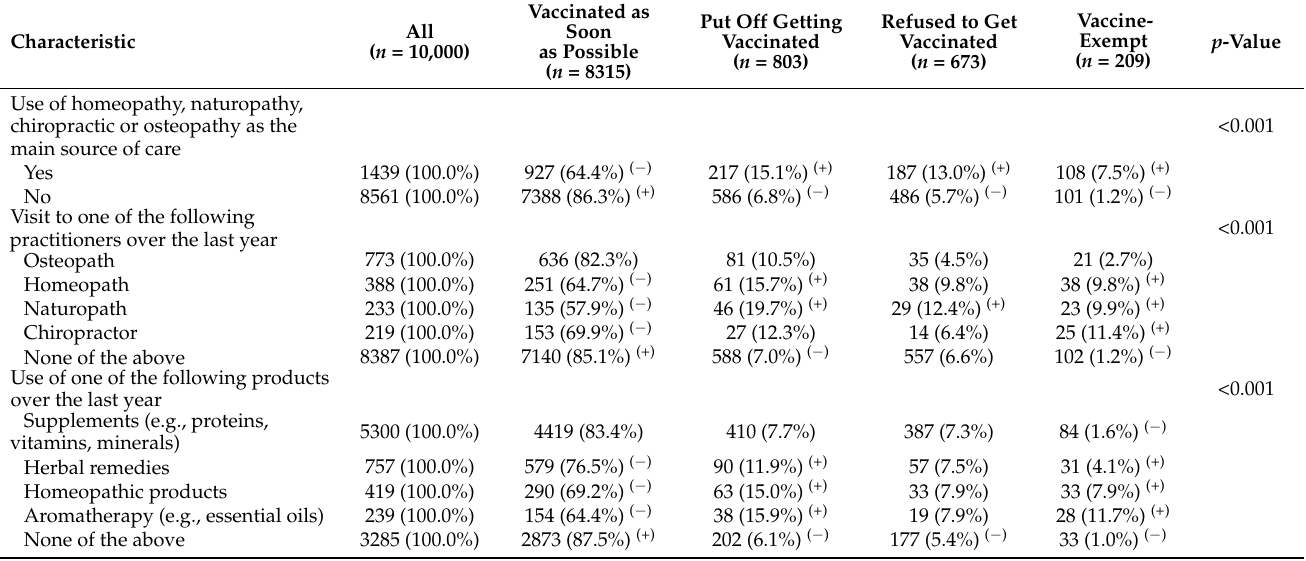
Table 2. Use of alternative medicine in the study sample, overall and by COVID-19 vaccine uptake sta- tus. Counts and percentages were obtained by weighting all observed values with post-stratification weights based on the distribution of Italy’s resident adult population by NUTS region, gender, and age